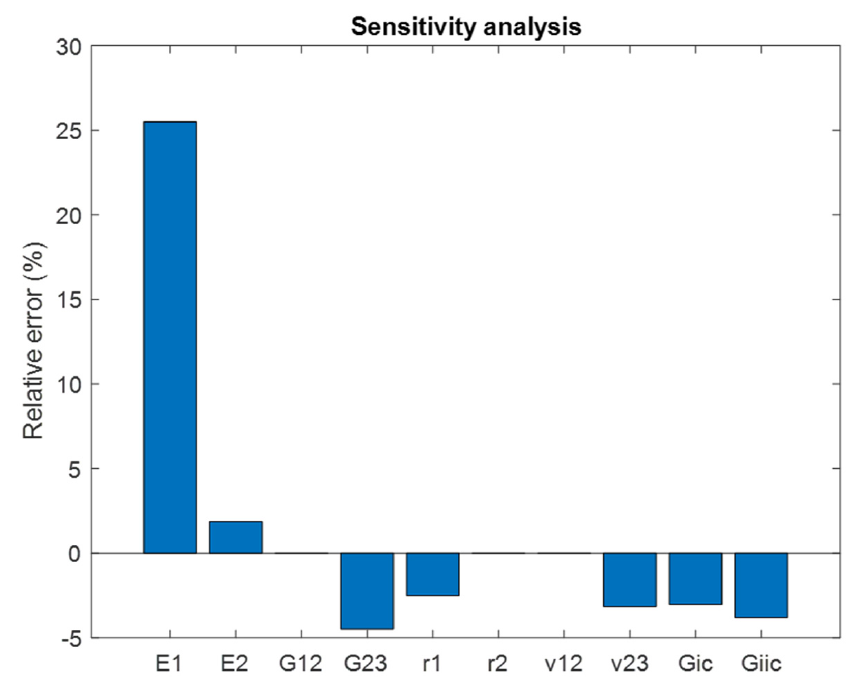
Figure 11. Sensitivity analysis plot representing the relative error of each parameter with respect to the exact simulation parameters fatigue behavior.